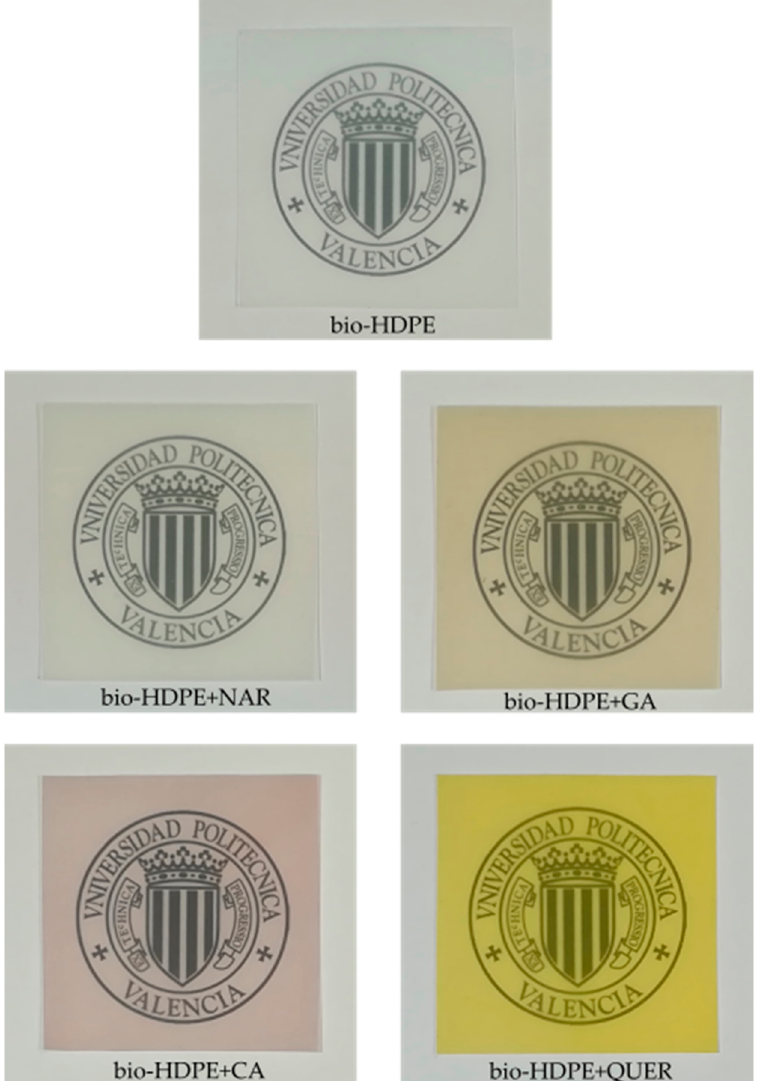
Figure 2. Visual appearance of the thermo-compressed bio-based high-density polyethylene (bio- HDPE) films containing naringin (NAR), gallic acid (GA), caffeic acid (CA), and quercetin (QUER). Color differences of the bio-HDPE films were quantified in Table 2 by the values of L * (luminance) and the a * (green to red) and b * (blue to yellow) coordinates as well as the color change, that is, Δ E ab *, after the incorporation of the different antioxidants. It can be noticed that the addition of 0.8 phr of each antioxidant caused a significant decrease in the luminance L * value, being more intense in the sample with CA, indicating that lightness was reduced in all the bio-HDPE films. One can observe that the GA-containing film de- veloped higher values of a * and b * of 0.19 and 13.26, respectively, corroborating the red- dish yellow coloring. Higher values of a *, that is, 4.80, but lower of b *, that is, − 1.32, were attained for the bio-HDPE film with CA, as an indication of the developed blueish red hue. The highest color variation was observed for the addition of QUER, having values of 0.57 and 49.00 for a * and b *, respectively, and supporting the development of a strong yellow color in the biopolymer film sample. In all cases, the Δ E ab * values were higher than 5, indicating that different colors can be easily noticed by an unexperienced observer. The highest color change was produced after the addition of QUER, having a value of Δ E ab * of 54.47. Similarly, Marcos et al. [41] showed that the incorporation of 2.82 wt% of α –tocoph-